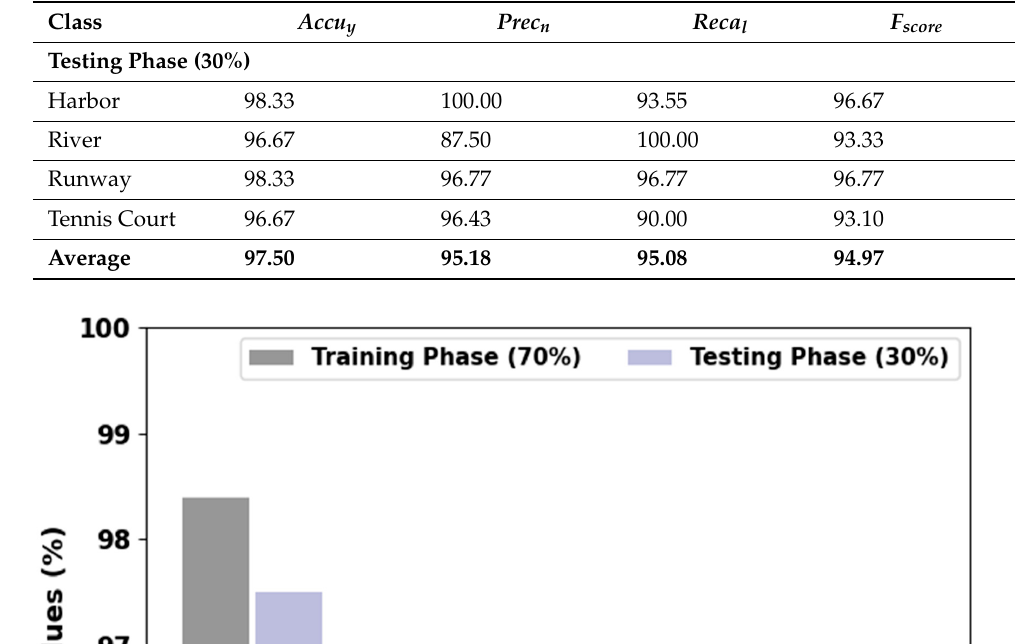
Table 5. Classification results of the proposed BSBE-PPODLC approach on 70:30 on TR/TS datasets.